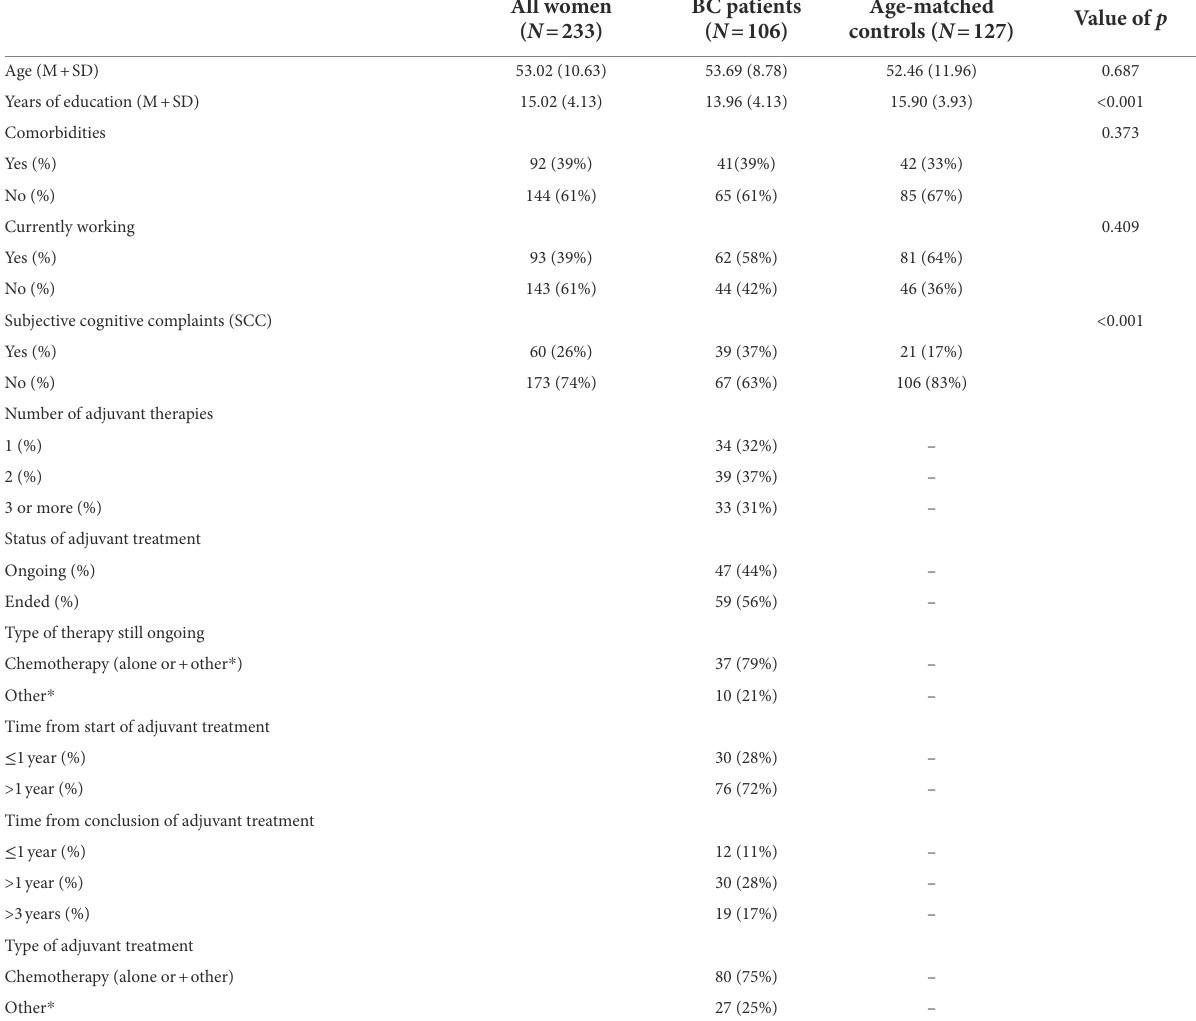
TABLE 1 Descriptive statistics for breast cancer (BC) patients and age-matched